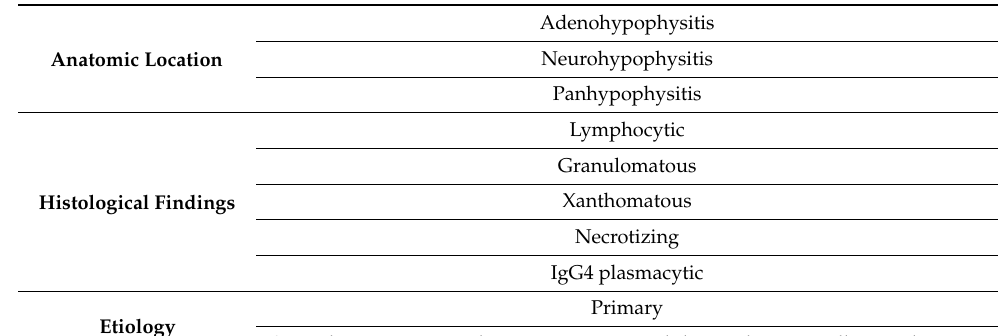
Table 1. Classification of hypophysitis. Modified from Leporati et al.